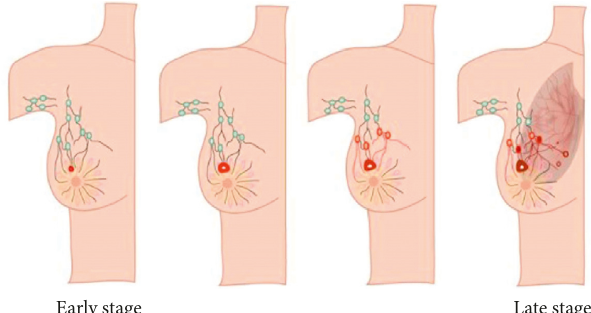
Figure 2: Detection of breast cancer stages by applying IoT [13].